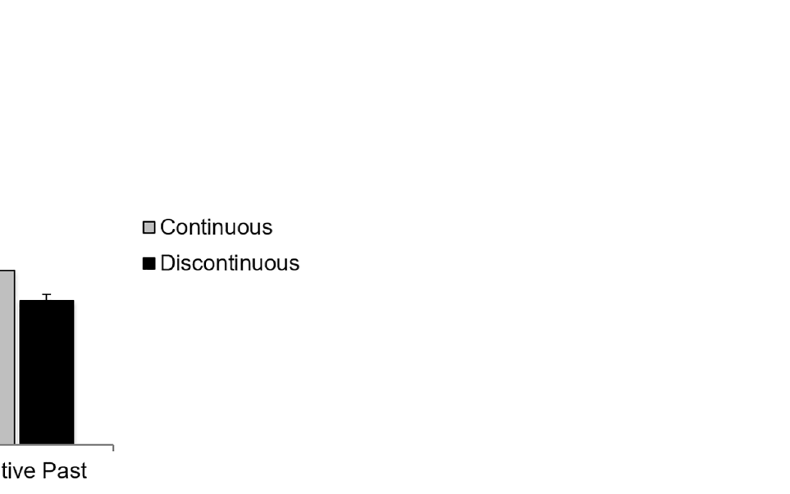
Figure 1. Perceived identity threat depending on whether the in-group’s history is presented as continuous or discontinuous and the valence of the past